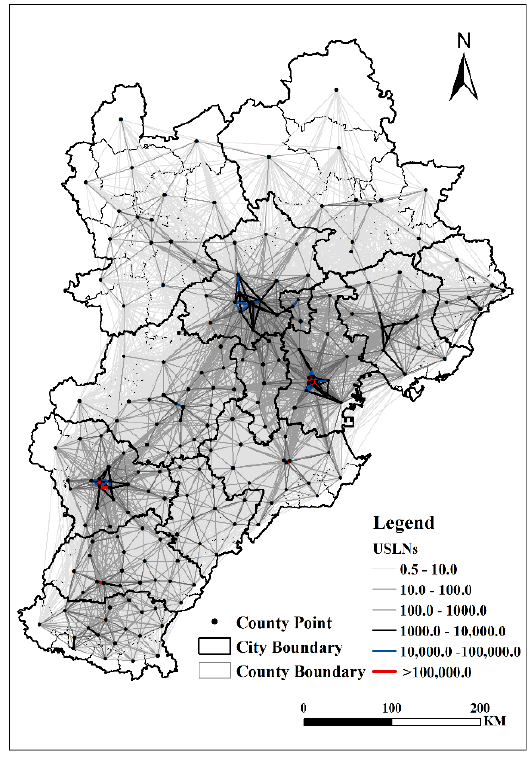
Figure 7. Urban spatial linkage network of the BTH region.